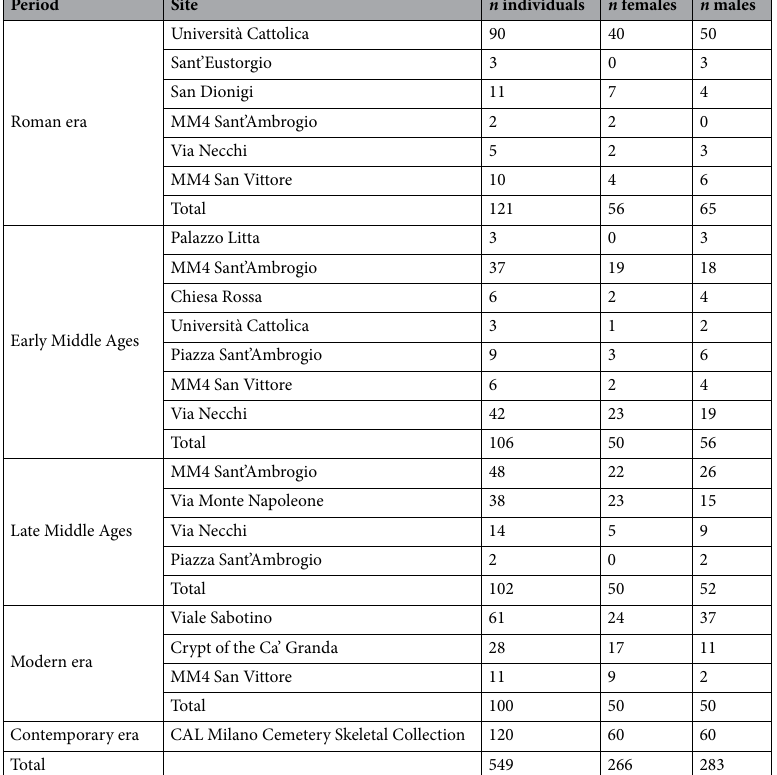
Table 1. Details on the study